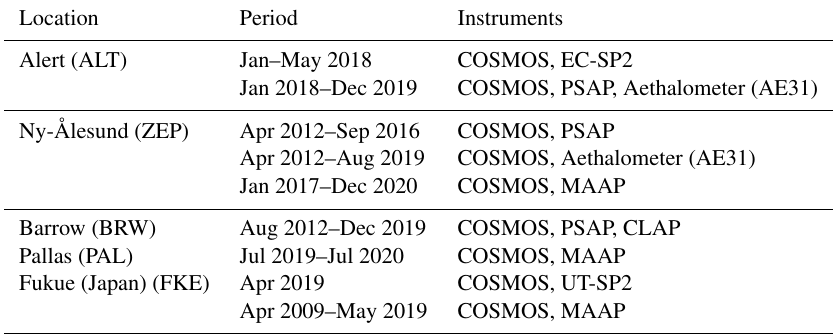
Table 1. Observation sites, periods, and instruments used in this